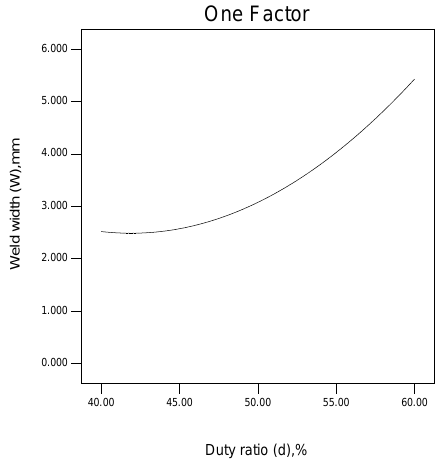
Figure7. Influence of duty ratio on weld width.